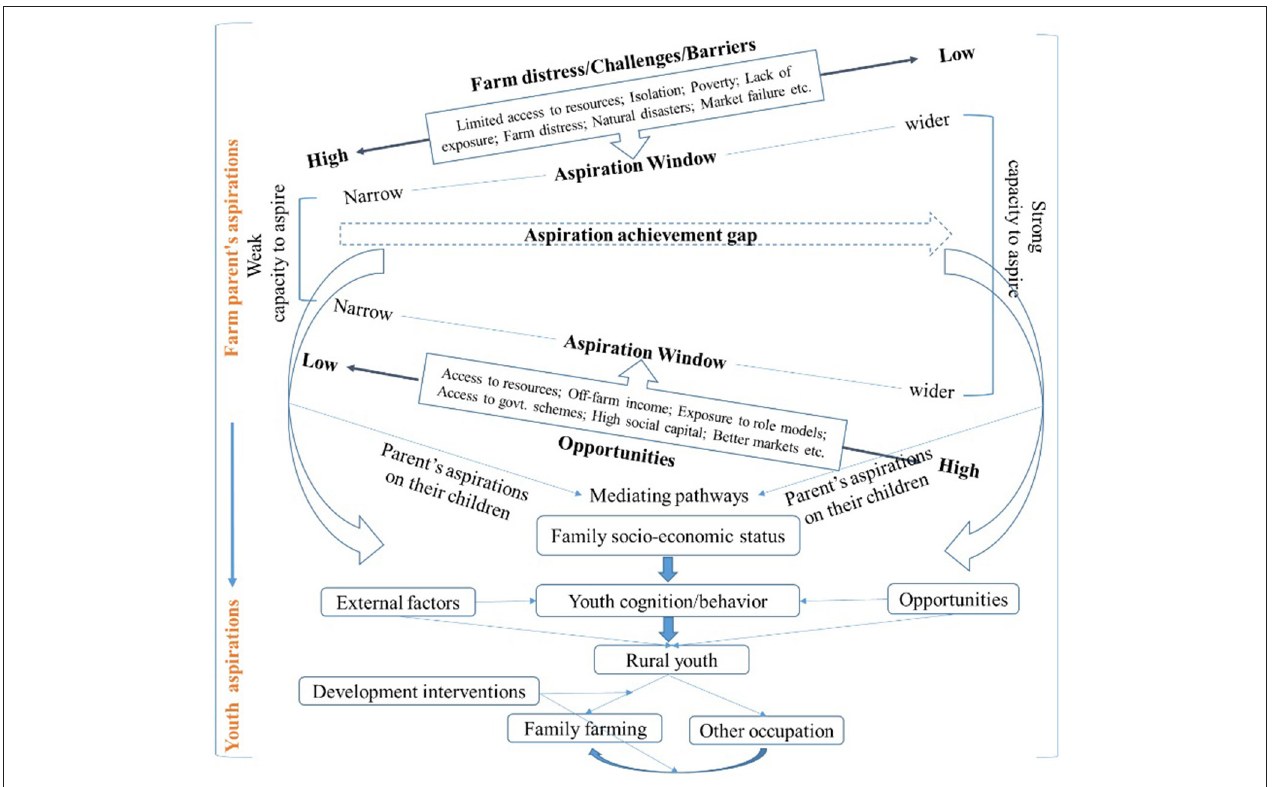
FIGURE 1 | Conceptual framework: factors shaping the intergenerational formation of aspirations in agriculture.